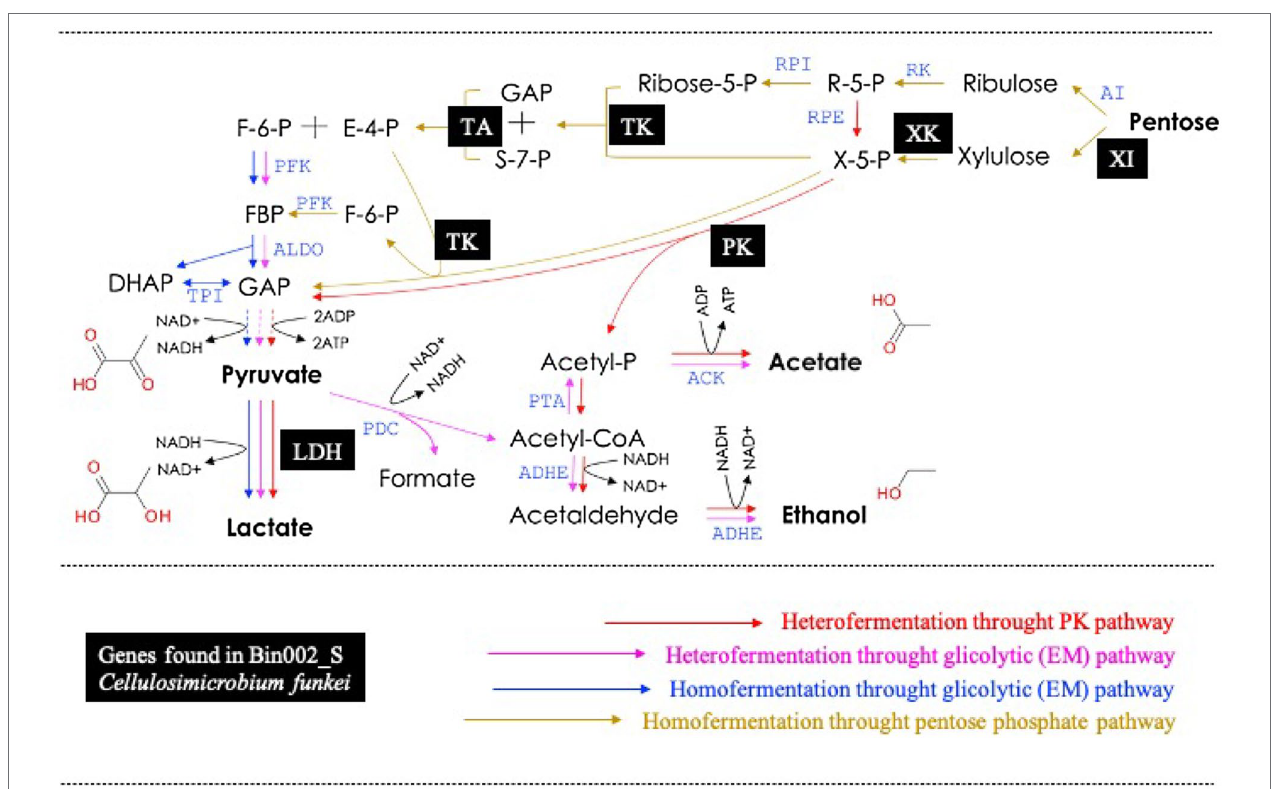
FIGURE 6 | Metabolic pathway for pentoses dissimilation in lactic acid bacteria (modified from Hatti-Kaul et al., 2018). Black squares represent the genes found in the Bin002_S ( Cellulosimicrobium funkei ). XI, xylose isomerase; XK, xylulose kinase; TK, transketolase; TA, transaldolase; PK, phosphoketolase; and LDH, lactate dehydrogenase. For details in all abbreviations see Hatti-Kaul et al.